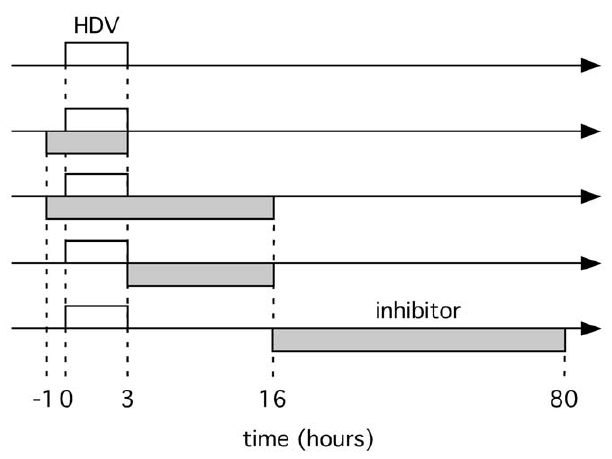
Figure 2. Representation of time-lines for exposure of primary hepatocytes to HDV and potential inhibitors. For the five time- lines shown the open box indicates the period of HDV exposure and the shaded box the exposure to inhibitor. The effects on HDV replication of such treatments with three different inhibitors are summarized in Table 1.